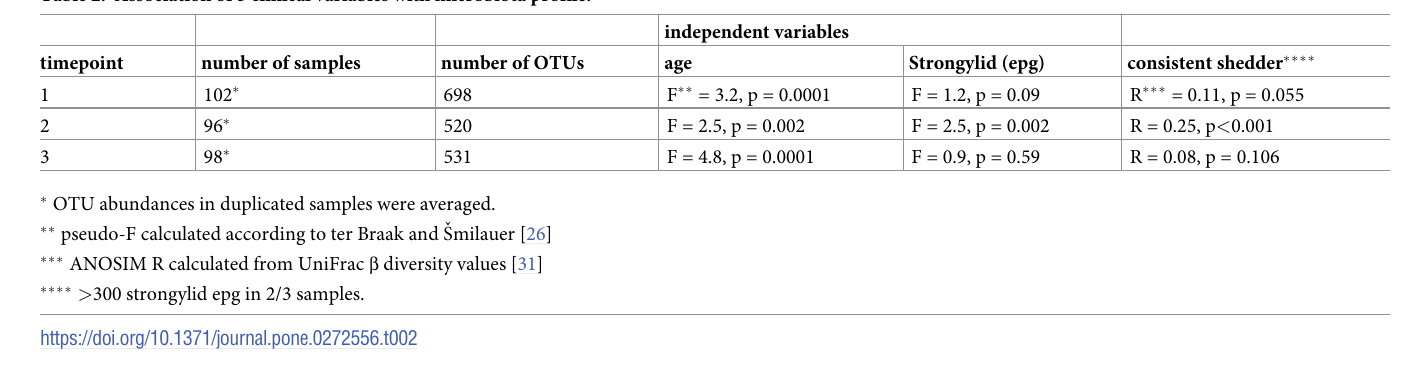
Table 2. Association of 3 clinical variables with microbiota